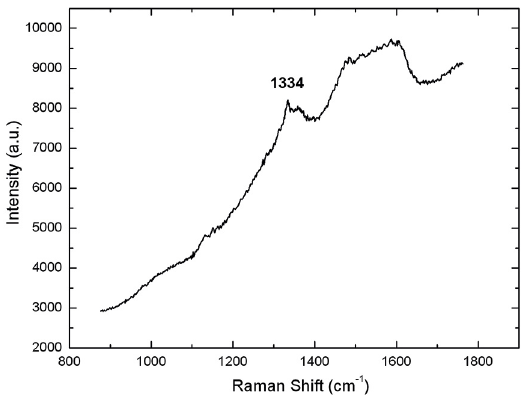
Figure 7. Raman spectrum of diamond film on AISI 304L with SiC interlayer.